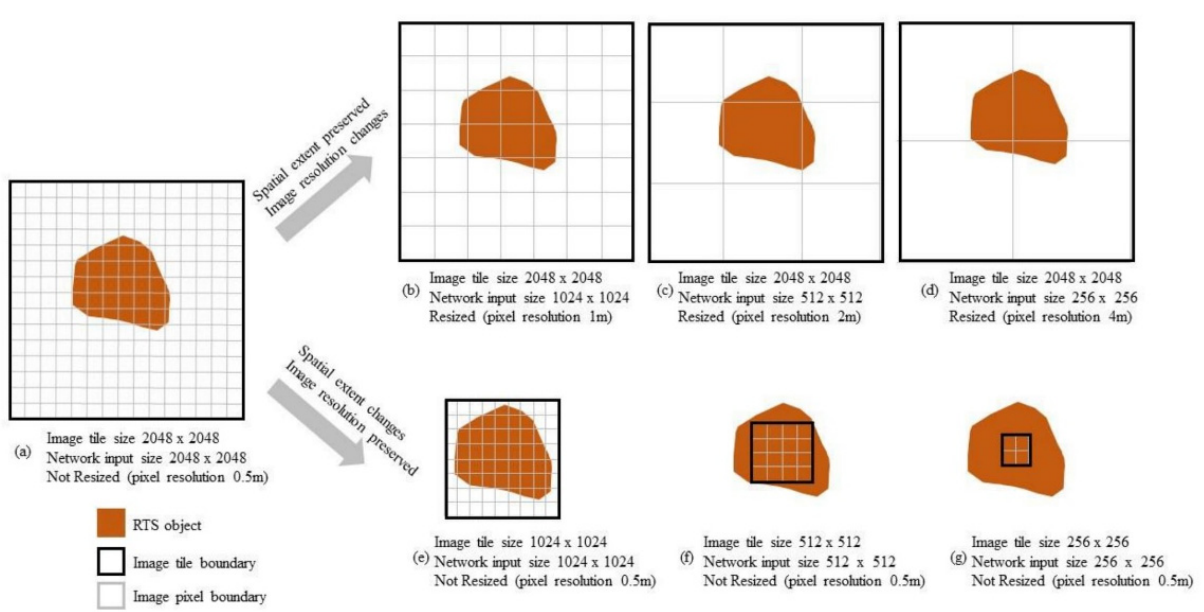
Figure 4. Image tile size and network input size scenarios considered in the analysis. As an example, here are the scenarios associated with an image input tile size of 2048 × 2048: The original image scene resolution (pixel size) is 0.5 m. ( a ) Image scene is partitioned into image tiles with the size of 2048 × 2048 pixels. The network input size is also 2048 × 2048 pixels. The original resolution (0.5 m) is unchanged. ( b ) Image scene is partitioned into image tiles with the size of 2048 × 2048 pixels. The network input size is 1024 × 1024 pixels. The original resolution (0.5 m) has degraded to 1 m. ( c ) Image scene is partitioned into image tiles with the size of 2048 × 2048 pixels. The network input size is 512 × 512 pixels. The original resolution (0.5 m) has degraded to 2 m. ( d ) Image scene is partitioned into image tiles with the size of 2048 × 2048 pixels. The network input size is 256 × 256 pixels. The original resolution (0.5 m) has degraded to 4 m. ( e ) Image scene is partitioned into image tiles with the size of 1024 × 1024 pixels. The network input size is 1024 × 1024 pixels. The original resolution (0.5 m) is preserved. ( f ) Image scene is partitioned into image tiles with the size of 512 × 512 pixels. The network input size is 512 × 512 pixels. The original resolution (0.5 m) is preserved. ( g ) Image the size 256 × 256. Network input size 256 × 256. Not resized (pixel resolution 0.5 m).